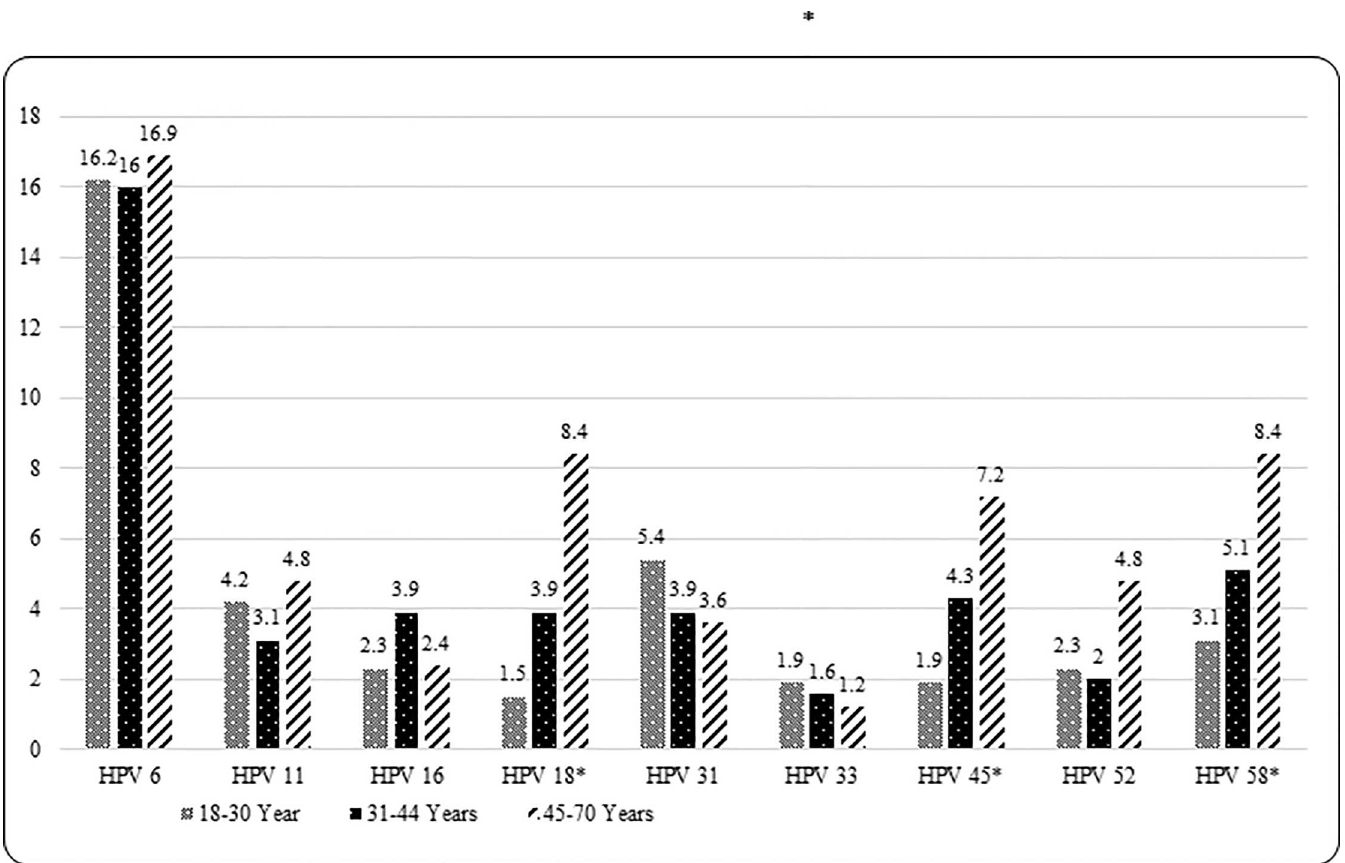
Fig 2. Type-specific seroprevalence of nine HPV vaccine types by age group. Significantp-value < 0.05 is marked with ‘ * ’. P-value was obtained from Cochran-Armitage Trend Test. P trend < 0.05 for HPV types 18, 45 and